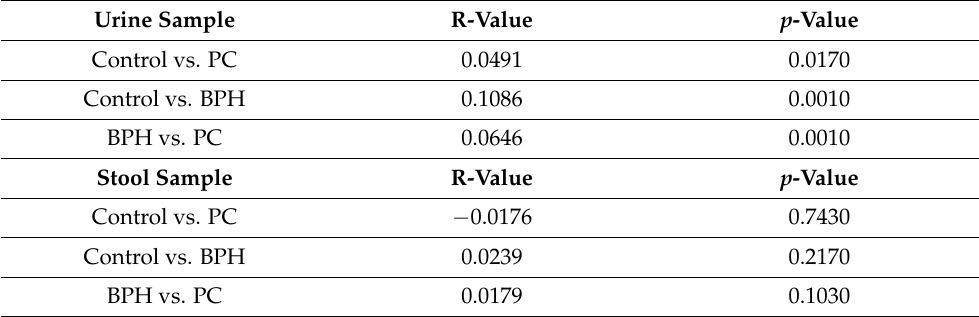
Table 2. ANOSIM analysis of BPH, PC, and control group microbiota composition of urine and stool